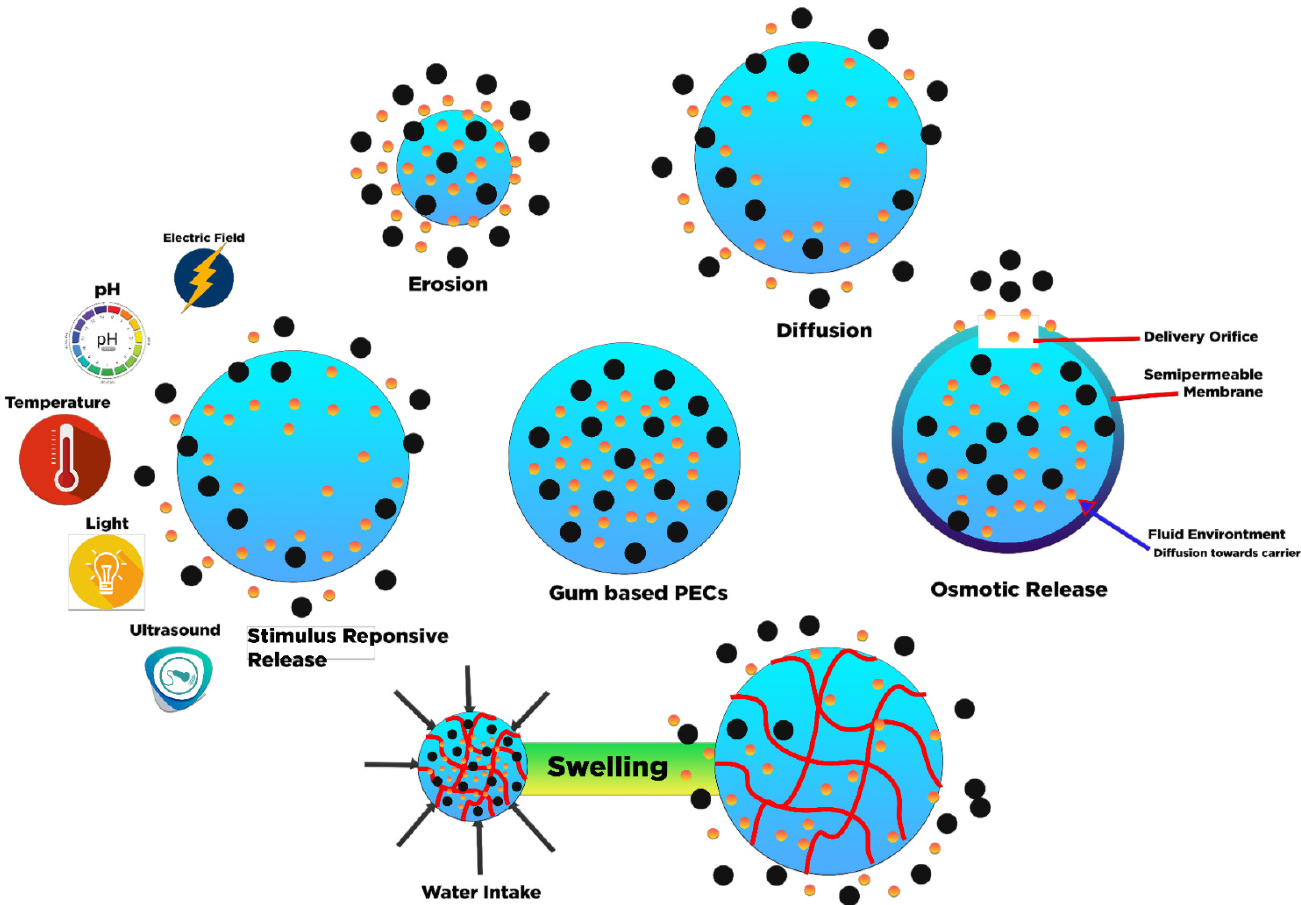
Figure 3. Schematic of drug release mechanism.